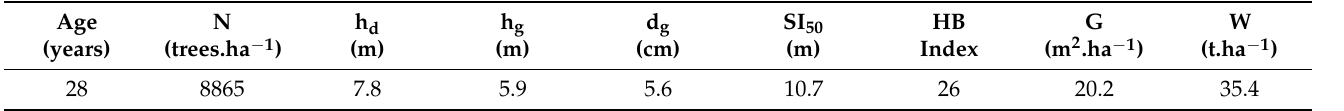
Table 1. General biometric parameters of the experimental trial of Pyrenean oak coppice (before